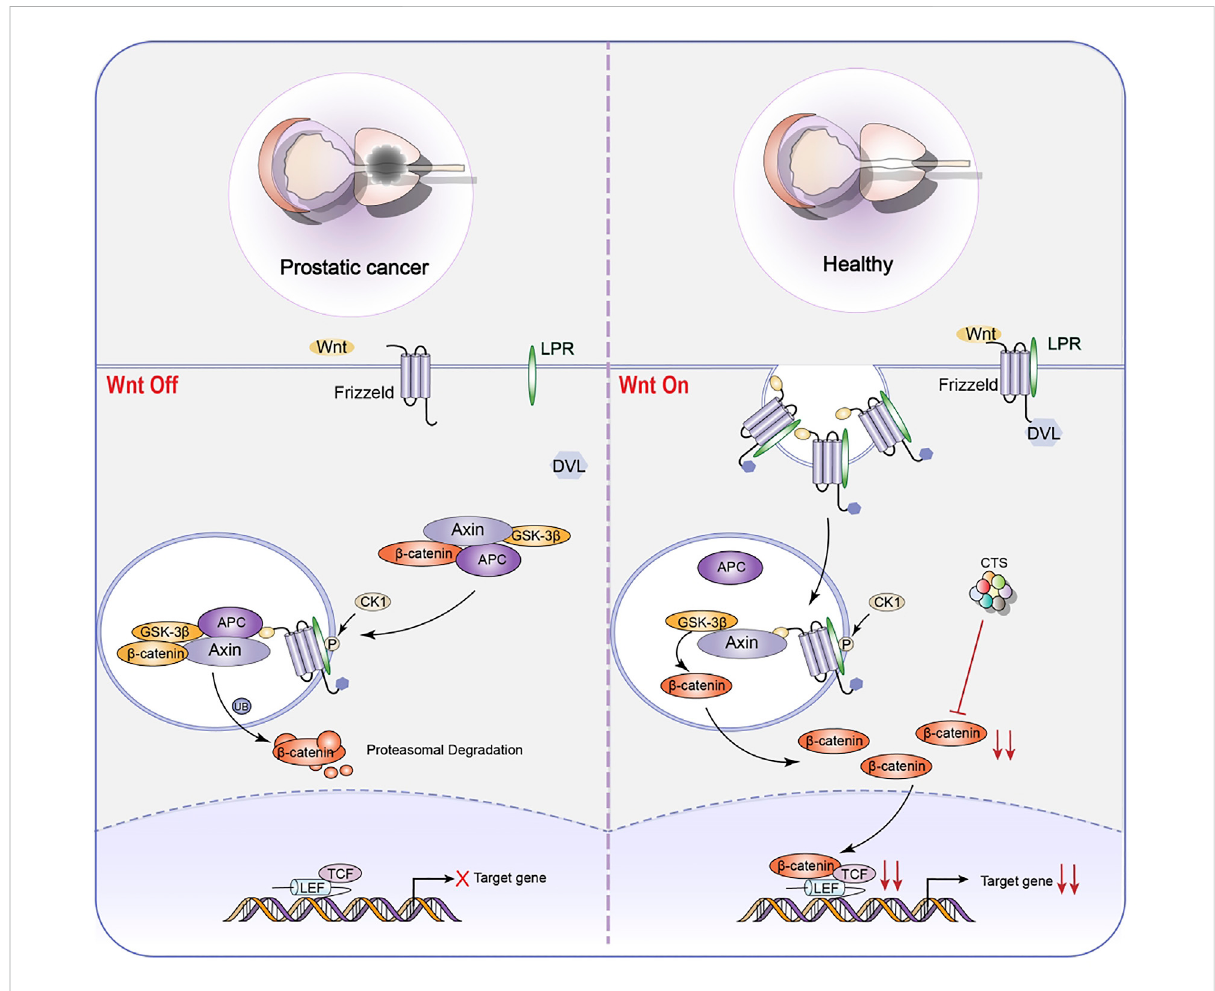
FIGURE 6 Representative scheme illustrating CTS ’ s inhibitory role in the proliferation of LNCaP TICs by regulating the Wnt signaling pathway for the treatment of prostatic